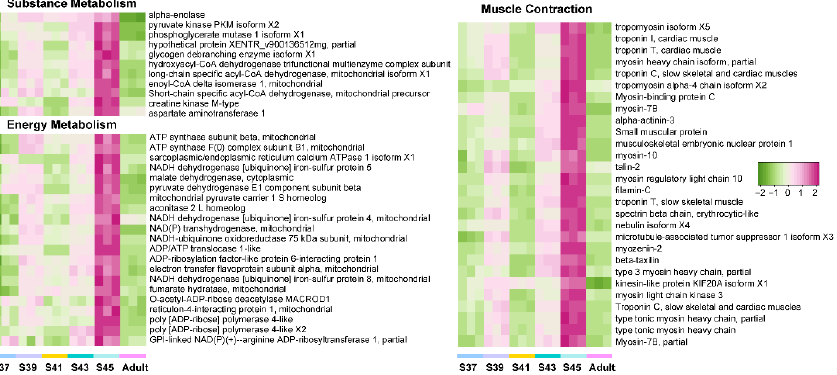
Figure 5. The variation patterns of featured genes involved in substrate metabolism, energy metabolism, and muscle contraction in the post-metamorphic phase ( n = 3 each stage).